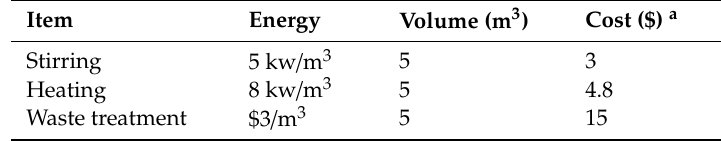
Table 7. Cost of energy consumption and waste disposal of reductive amination.